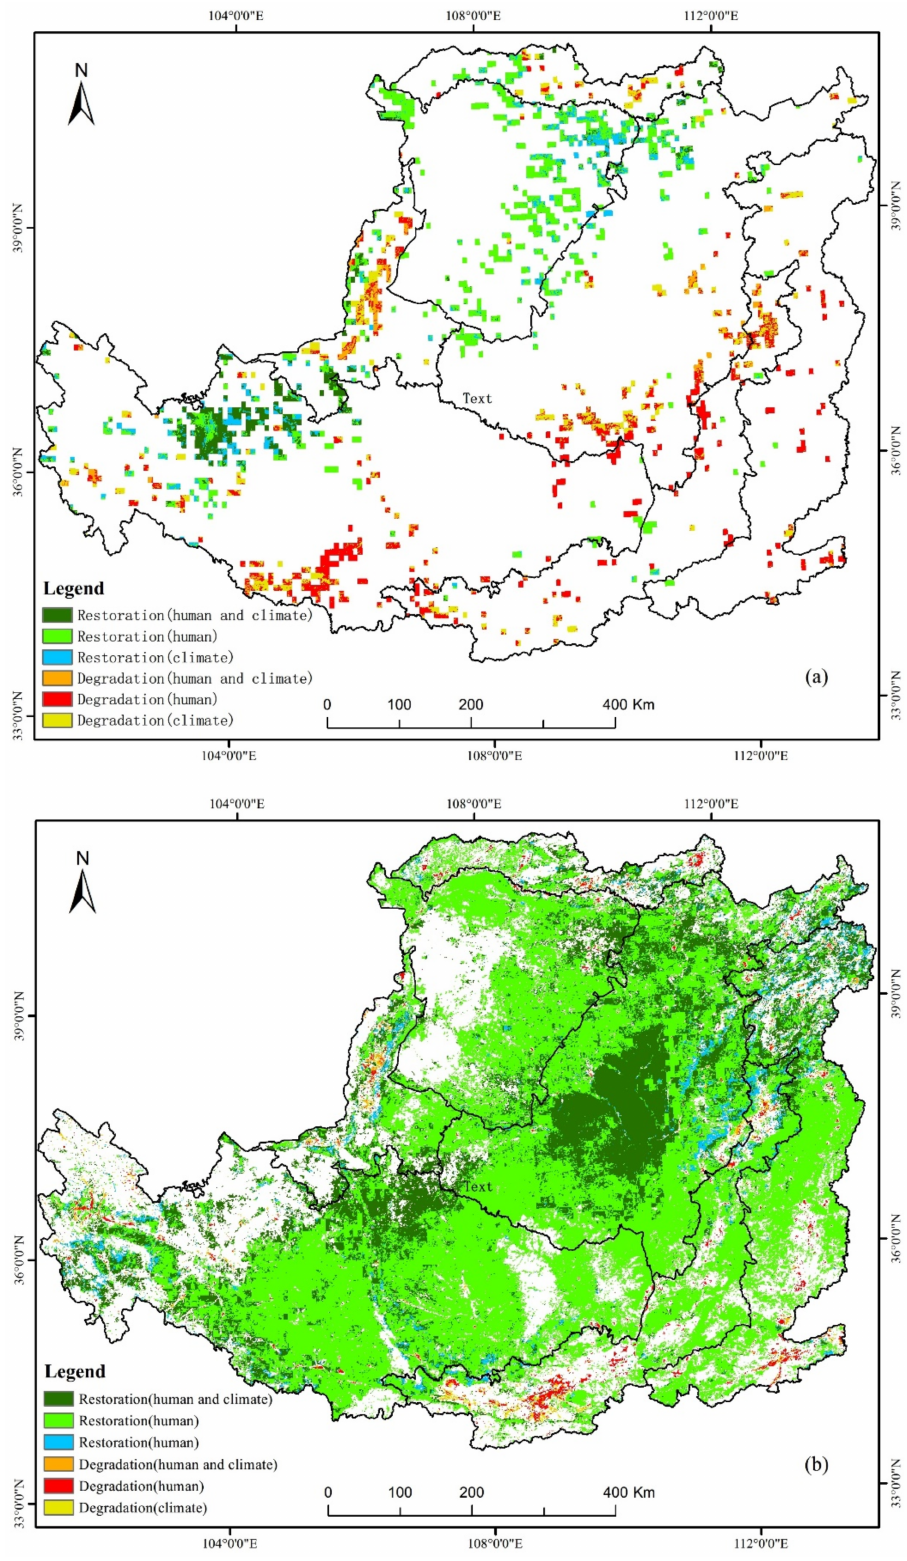
Figure 13. Distribution of driving factors of significant restoration and significant degradation of vegetation quality on the Loess Plateau before (( a ): 1990–1999) and after (( b ): 2000–2015) the implementation of ecological